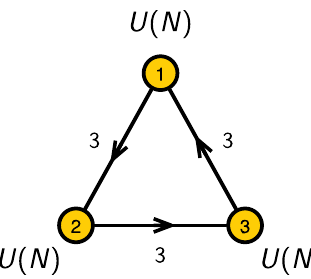
Figure 17 . Quiver diagram for N D3-branes probing C 3 = Z 3